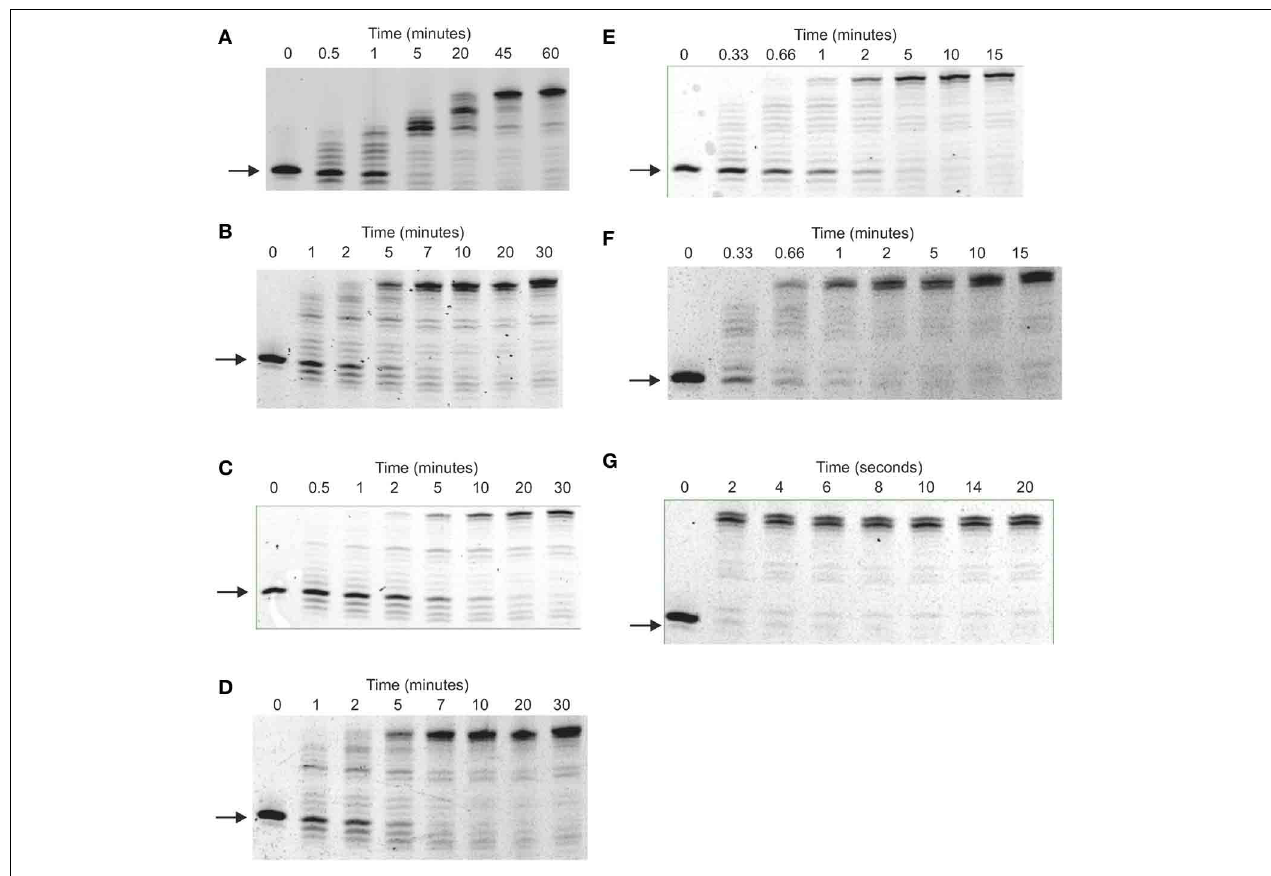
FIGURE 3 | Elongation of primer-templates by archaeal family-B DNA polymerases. Gel electrophoretic analysis of primer strand extension observed with: (A) Pfu-Pol wild type; (B) Pfu-Pol M247/L381; (C) Pfu-Pol L381R/K501R; (D) Pfu-Pol M247R/L381R/K501R; (E)